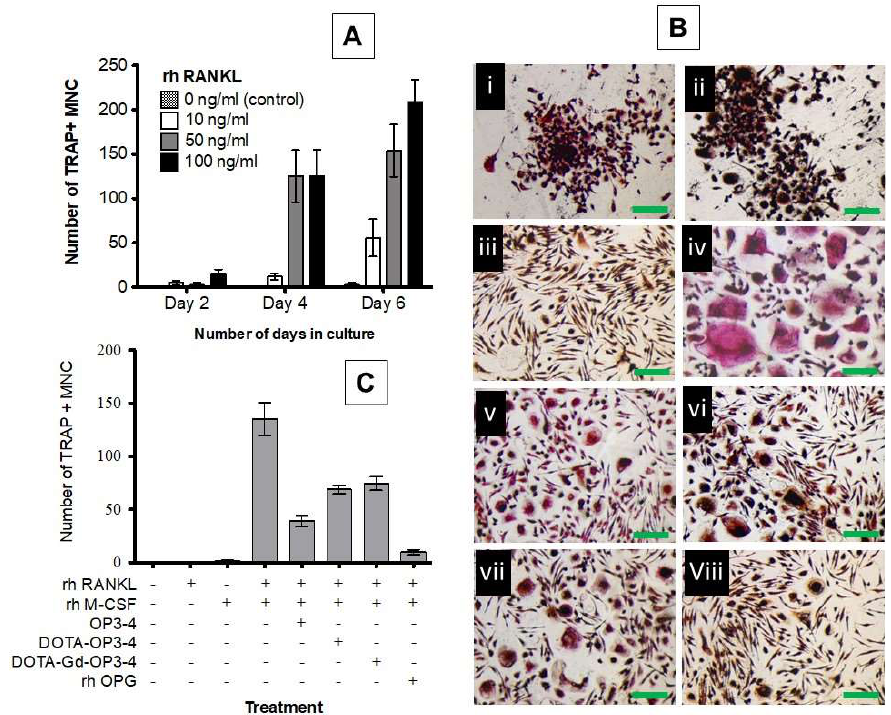
Figure 7. ( A ) Graphical representation of the effect of rh RANKL concentration and time in culture on osteoclastogenesis. ( B ) The effect of peptides on osteoclastogenesis after a four-day culture with ( i ) no cytokines or peptides, ( ii ) rh RANKL only, ( iii ) rh M-CSF only, ( iv ) rh RANKL and rh M-CSF, ( v ) OP3-4, ( vi ) DOTA-OP3-4, ( vii ) DOTA-Gd-OP3-4, and ( viii ) rh OPG (positive control): iv–ix had rh RANKL (50 ng/mL) and rh M-CSF (25 ng/mL). ( C ) Graphical representation of osteoclastogenesis inhibition by OPG mimetic